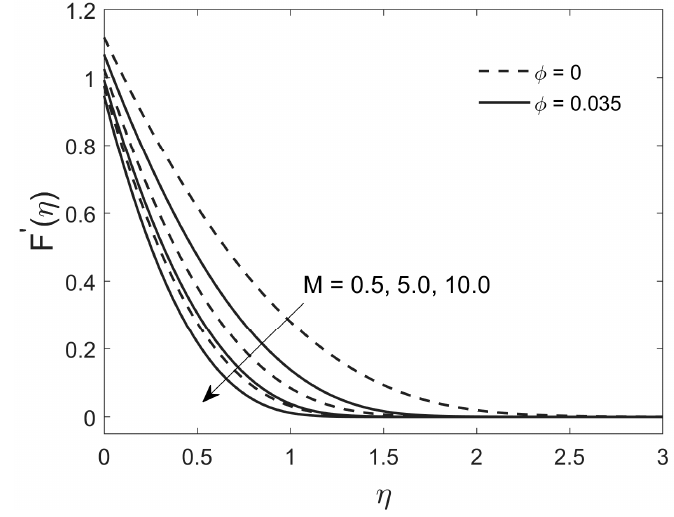
Figure 2. Effect of a magnetic field on the velocity profile.